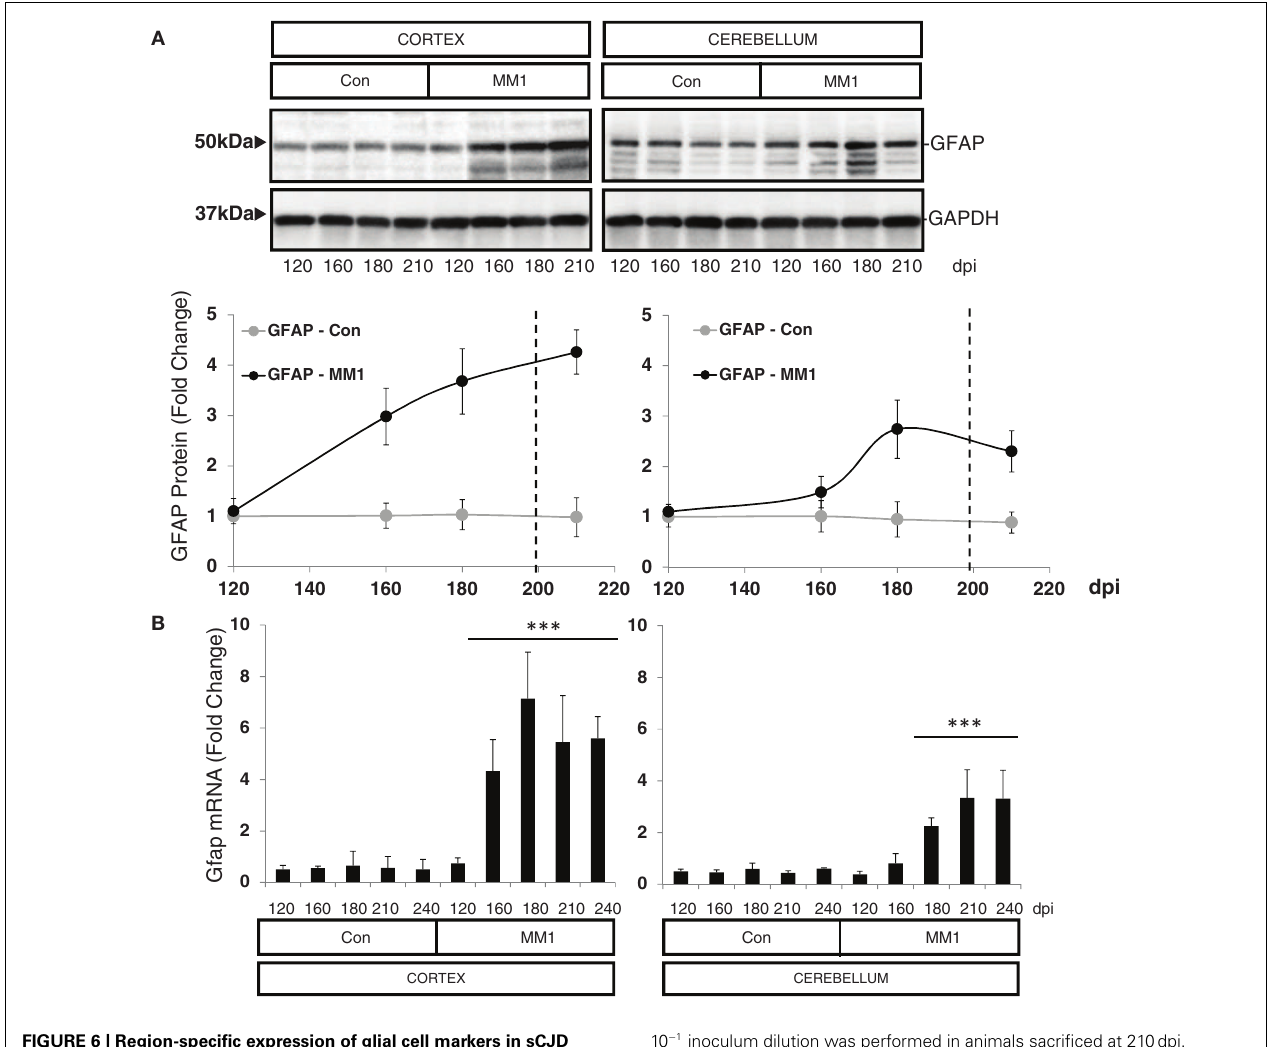
FIGURE 6 | Region-specific expression of glial cell markers in sCJD MM1 mouse model is shown . (A) Western blot analysis of GFAP in the cortex and cerebellum of control and sCJD MM1 mice at different dpi.